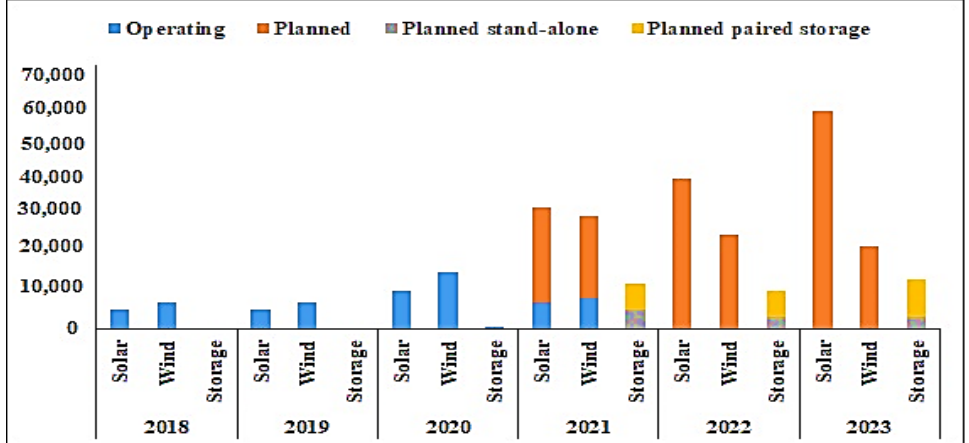
Figure 5. The annual installed capacity of wind, solar and battery storage [40].